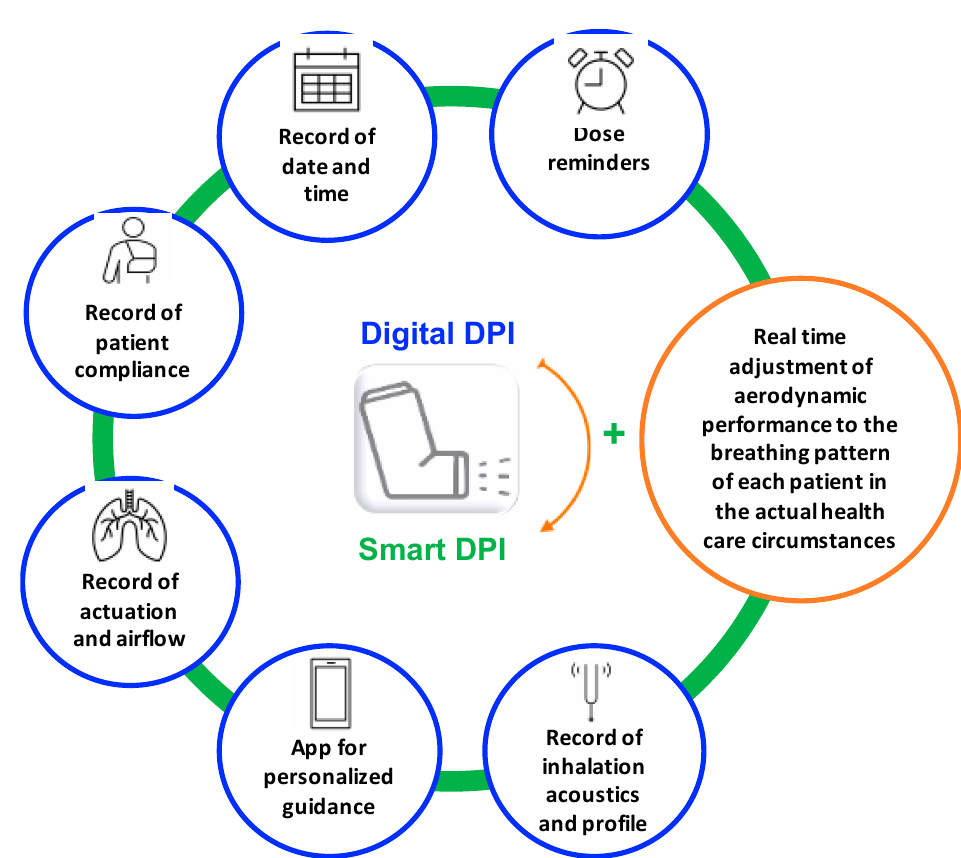
Figure 1. Summary of the available digital functions of the current digitalized DPIs arsenal. The requirement for “smart” device features, according to a generally recognized definition, also defines the gap that exists today between digital and smart devices.